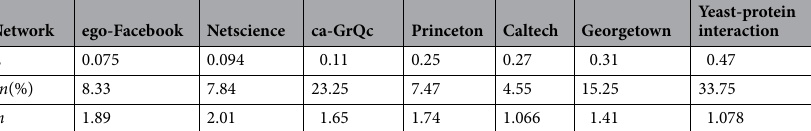
Table 1. The estimated mixing parameter μ , the proportion of the overlapping nodes on , and the average number of community memberships per node m of the real-world networks. These values are computed on the community structure uncovered using the SLPA algorithm.